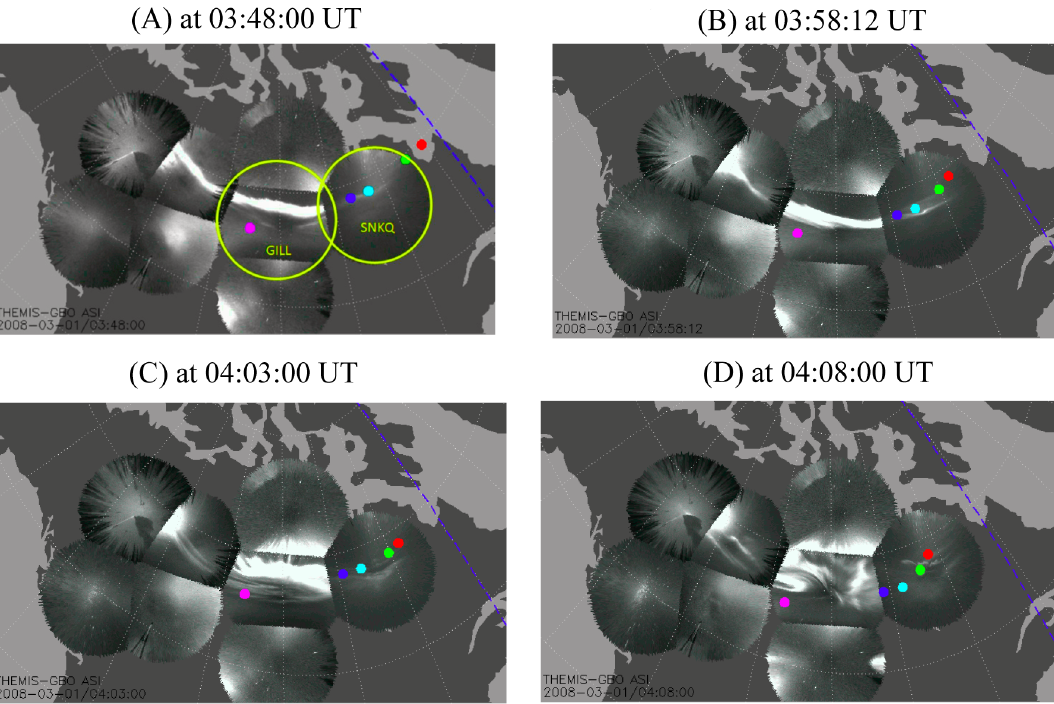
Fig. 4. (A) – (D) show mosaic ASI snapshots (of 3-s resolution) of the second event at four different times on 1 March 2008. We focus on the substorm activities of the second event (E-2) because the first event has been classified as a pseudo-breakup. Footprints of the THEMIS satellites are mapped using the AM02 field model of Kubyshkina et al. (2009). The yellow circles are the all-sky fields of view at GILL and SNKQ, respectively. The footprint of TH-D (turquoise dot) is located almost on top of the onset arc at SNKQ at